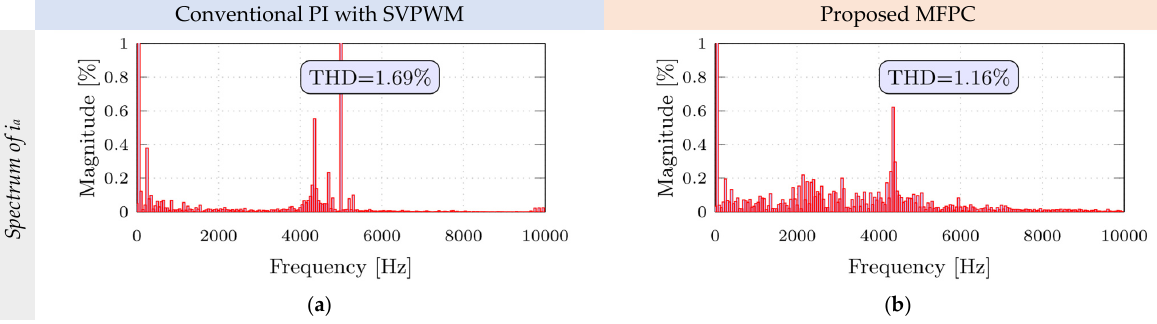
rent. As a result, in the case of MFPC, the THD of the grid current is smaller than in the